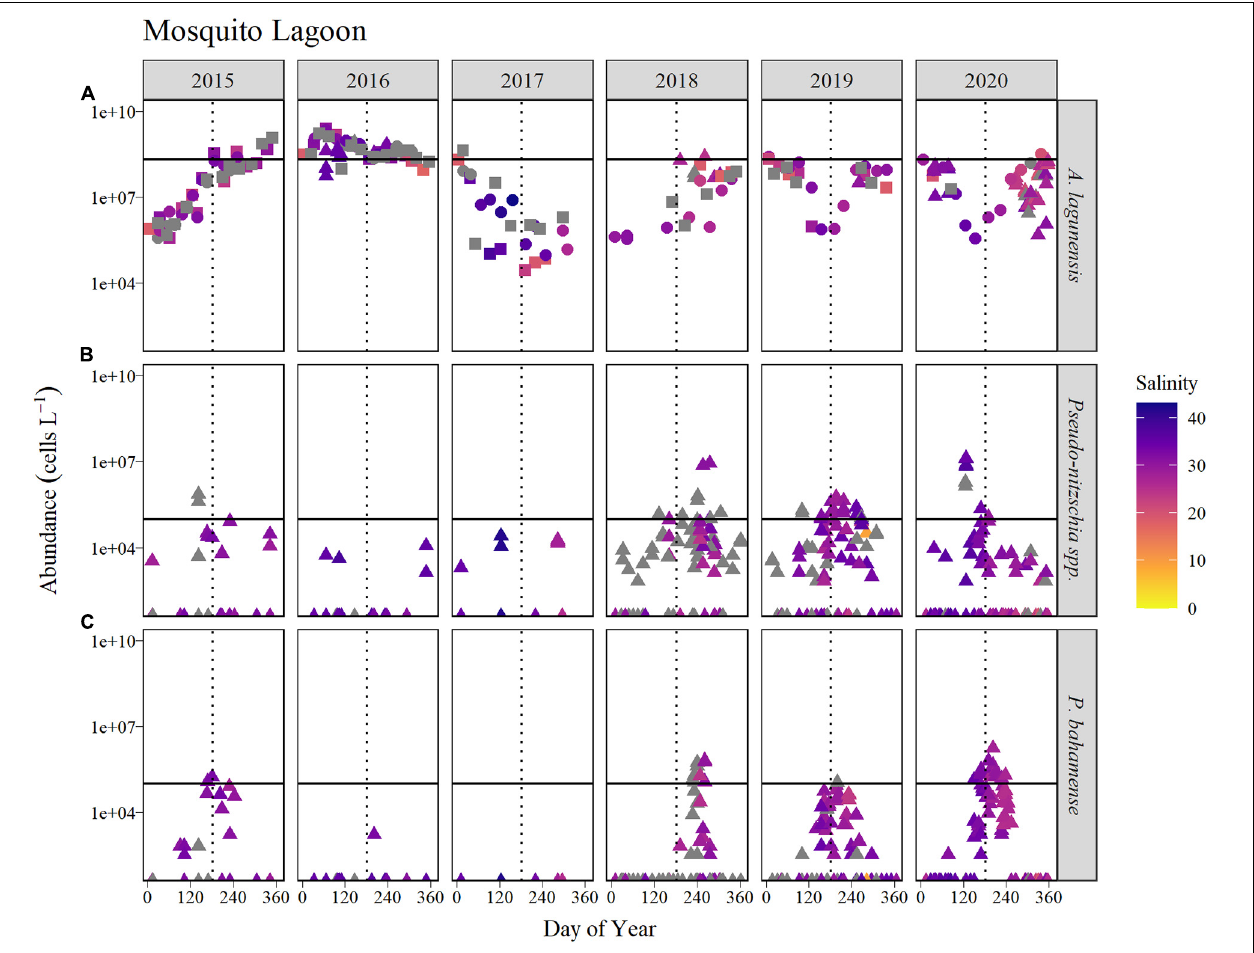
FIGURE 7 | Time course of abundance of (A) A. lagunensis cells, (B) Pseudo-nitzschia spp., and (C) P. bahamense presented on a logarithmic scale for the Mosquito Lagoon sub-basin for the years 2015 to 2020 (horizontal panels). Symbol color indicates salinity in corresponding discrete samples, shown as a gradient from the lowest salinities (orange) to the highest (blue). Gray symbols represent samples in which no discrete salinity was recorded. For A. lagunensis , abundance was determined by microscopic enumeration (FWC-FWRI, filled triangles; UF, filled squares) and by immunofluorescence flow cytometry (filled circles). The solid horizontal line indicates the bloom levels for each taxon ( A. lagunensis = 2 × 10 8 cells L − 1 , Pseudo-nitzschia spp., and P. bahamense = 10 5 cells L − 1 ). The vertical dotted line represents JD 182 (July 1, non-leap